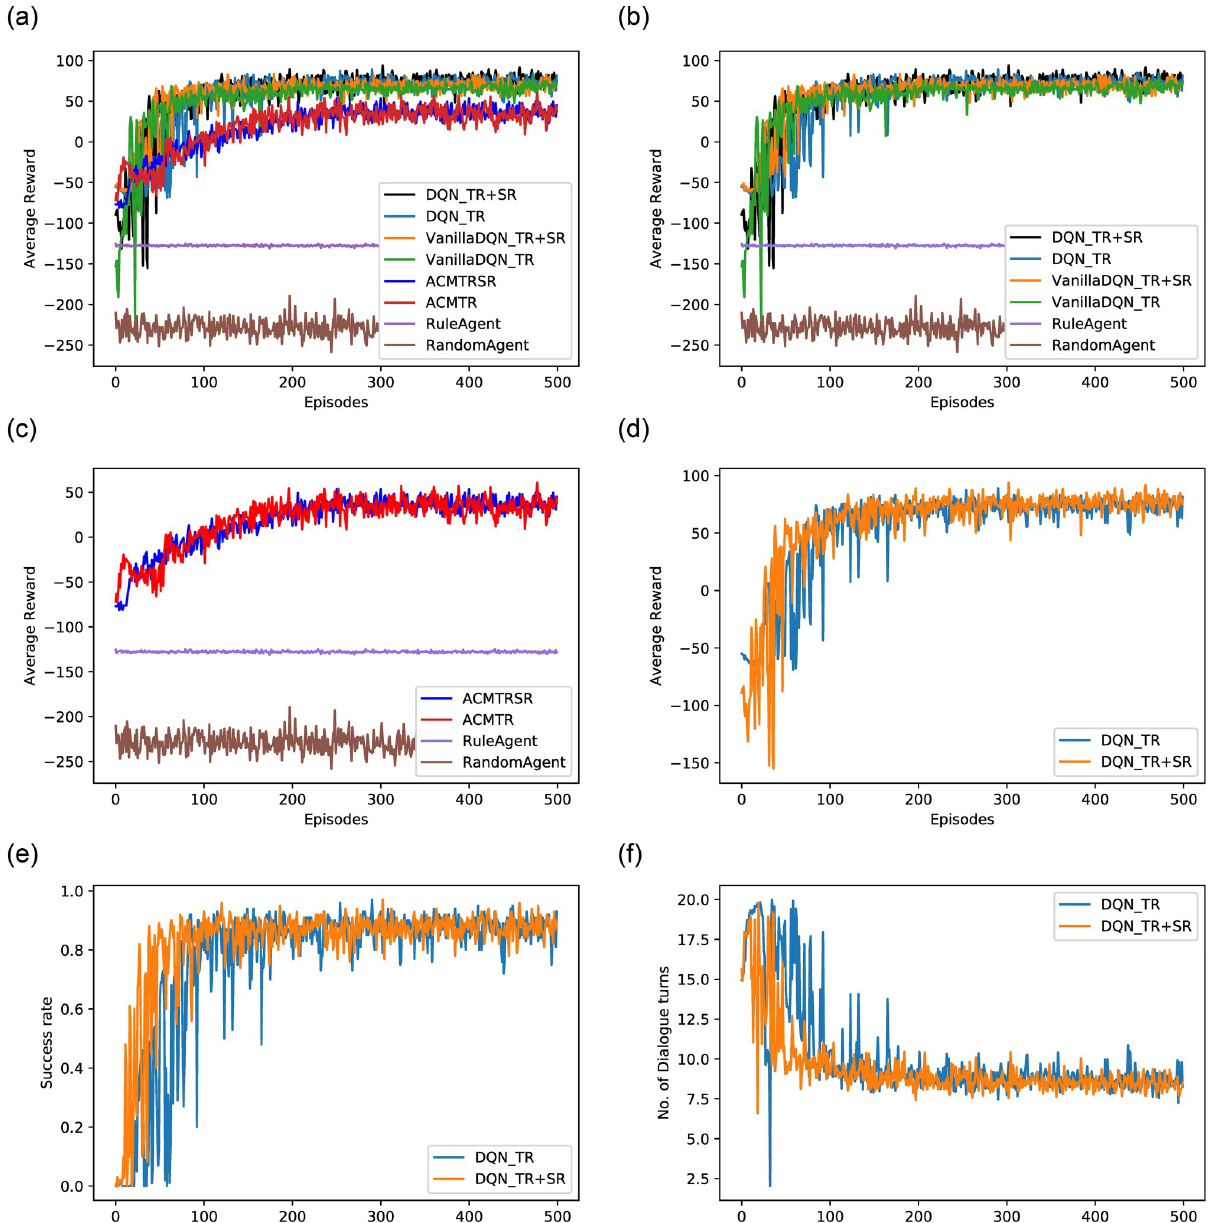
Fig 9. Learning Curves: (a) Learning graphs of different agents, b) Reward graph over episodes: Vanilla DQN and DDQN agents, c) Reward graph over episodes: Actor Critic, Rule agnet and Random agent, d) Reward graph over episodes: DDQN agents, (e) Success rate over episodes: DDQN agents, (f) Dialogue length over episodes: DDQN